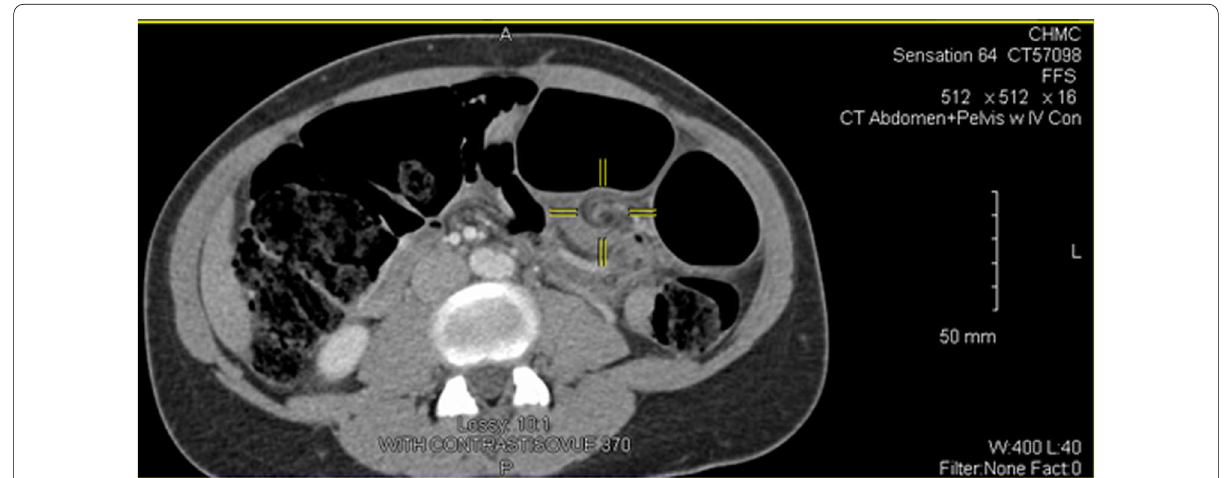
Fig. 1 Axial CT showing “whirl” sign (emphasized by the yellow cursor) and distended large bowel